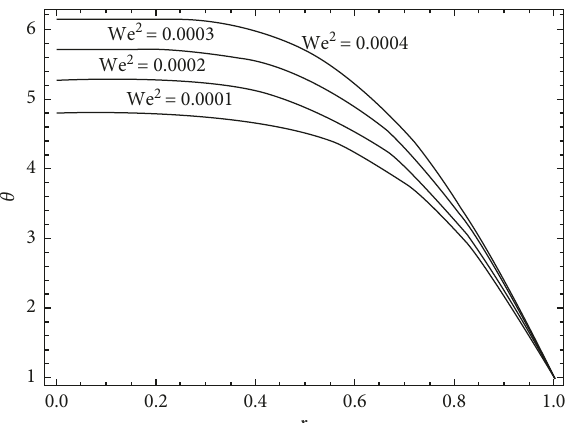
Figure 15: Variation of θ with r for different values of We 2 , where P 0 � 43, z � 0.1, B r � 1, K � 0.01, n � − 1, and m � 0.5.